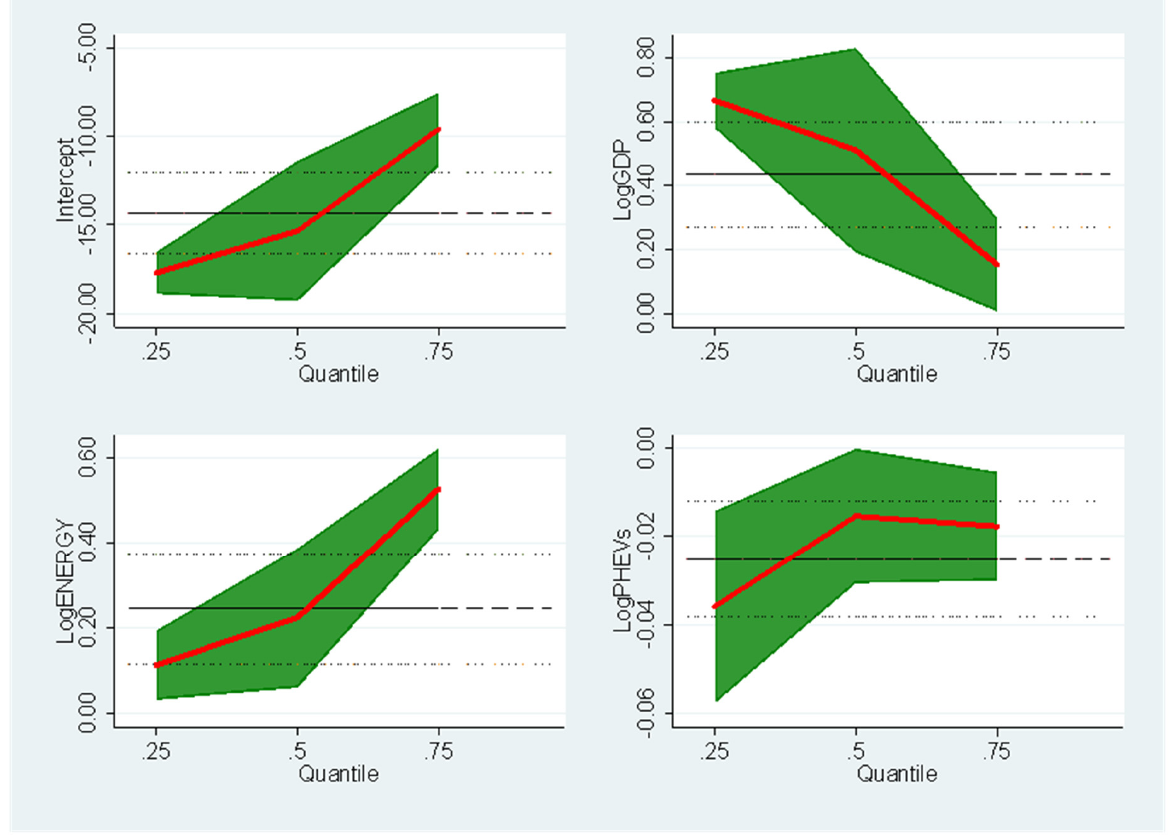
Figure 7. Quantile estimates.